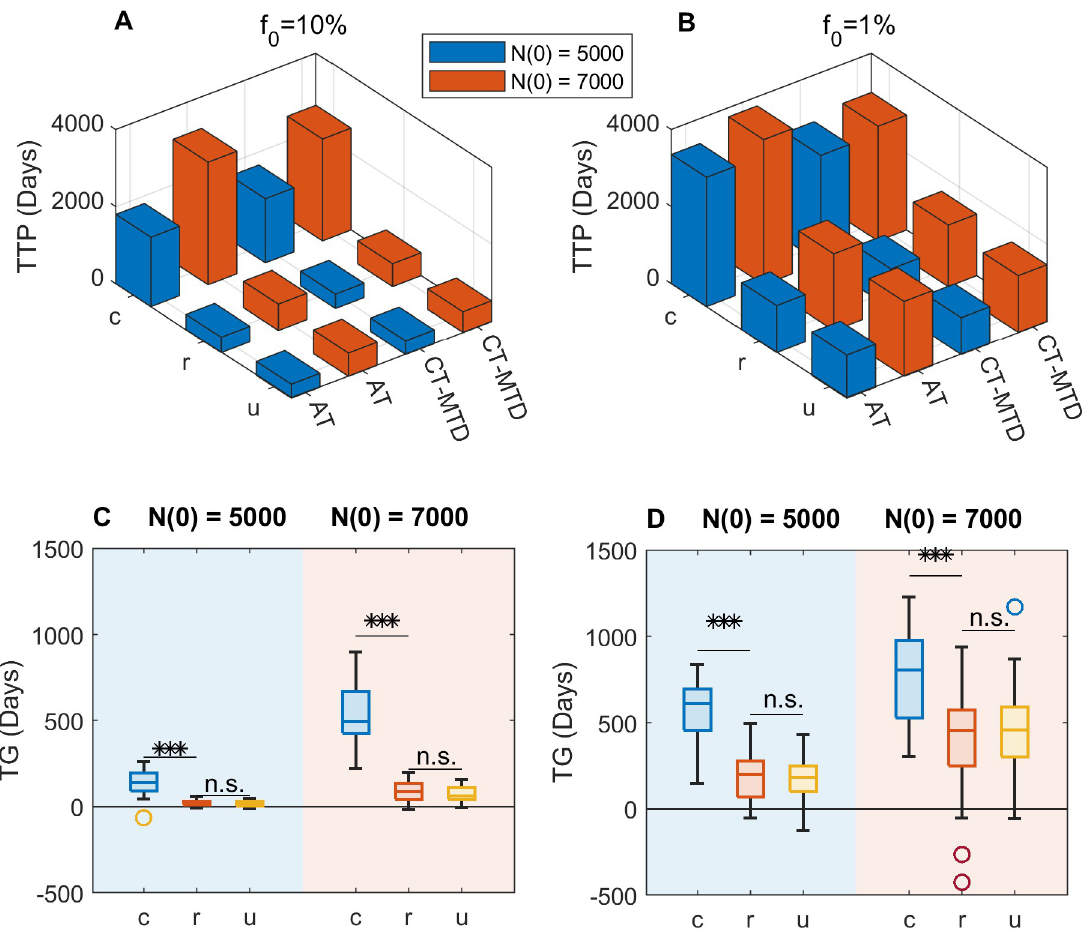
Fig 6. Role of the initial R-cell distribution on the benefit of AT over CT-MTD. ( A ) The blue and red bars show the TTP for N (0) = 5000 and 7000 respectively under both treatment strategies and different initial R-cell configurations of c (clumped), r(random) and u (uniform) for f 0 = 10%. ( B ) Similar results to those in A are shown for f 0 = 1%. ( C ) The boxplots show the TG in the 30 realizations for the clumped, random, and uniform initial cell configurations for f 0 = 10% ( ��� : p − value < 0.001; n.s.: not significant). The blue shaded and orange shaded regions show results for N (0) = 5000 and 7000 respectively. ( D ) Similar results to those in C are shown for f 0 =